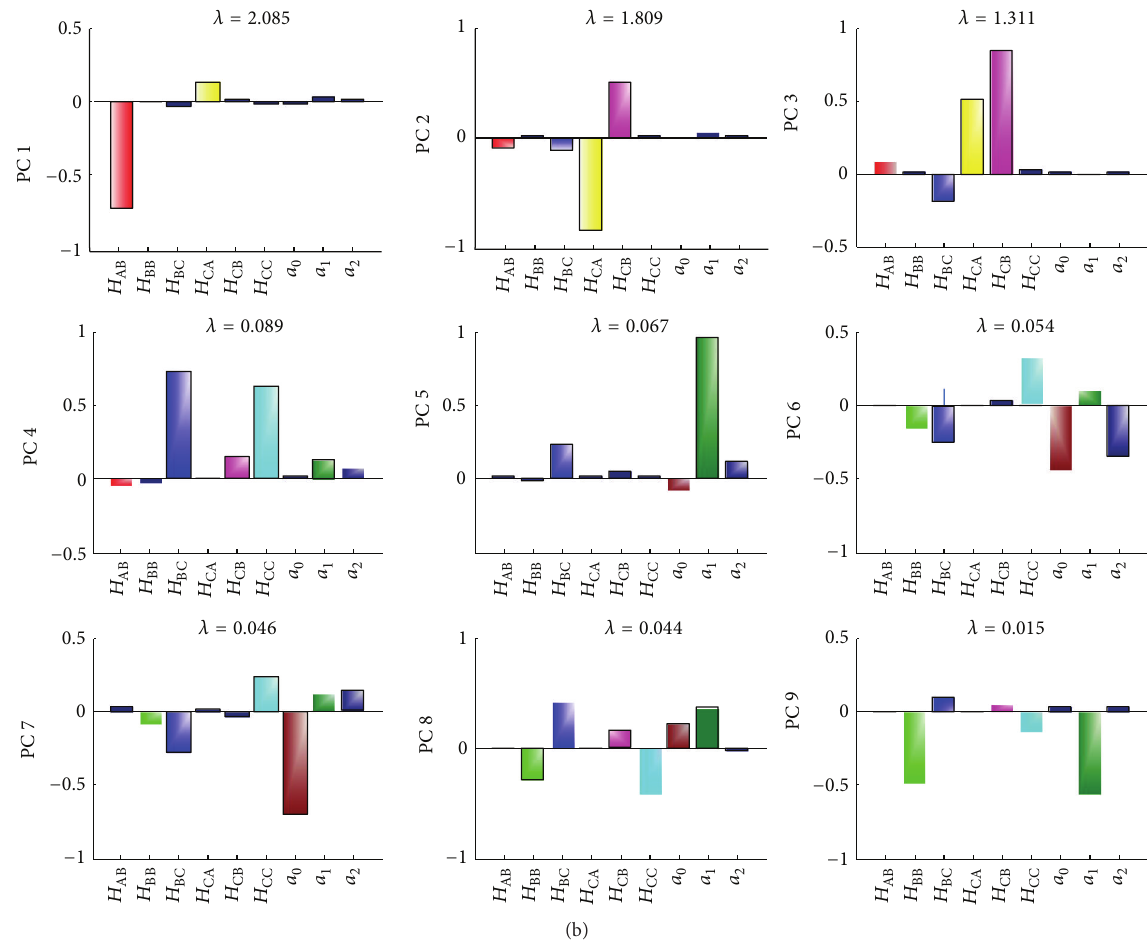
Figure 3: (a) Parameter posterior distribution for biological circuit 1. 𝑎 0 and 𝑎 1 are the normalized degradation time scales for components A andB,respectively.(b)Principalcomponentanalysisoftheposteriordistributionformodel1.PC1isthefirstprincipalcomponent(accounting for as much of the variability in the data as possible), while PC9 describes the direction of least variance and therefore the most sensitive parameters. 𝑎 0 , 𝑎 1 , and 𝑎 2 are the degradation constants for components A, B, and C, respectively. 𝜆 indicates the eigenvalue of variance covariance